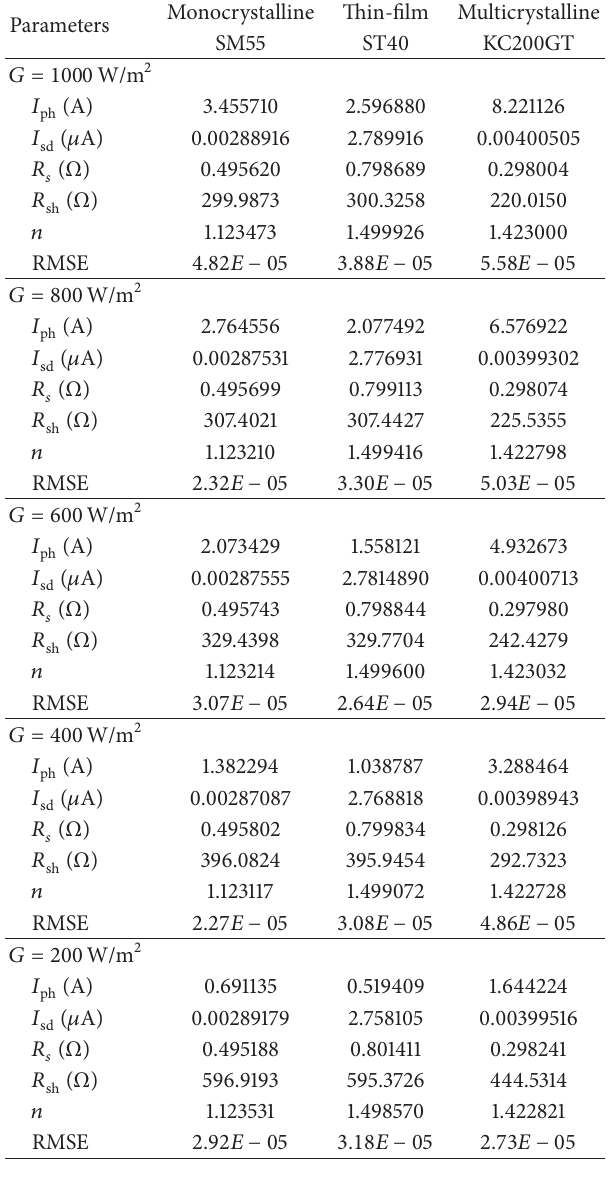
Table 13: The extracted parameters for monocrystalline SM55 PV module by PCE at different temperatures and values of irradiance of 1000 W/m 2 .